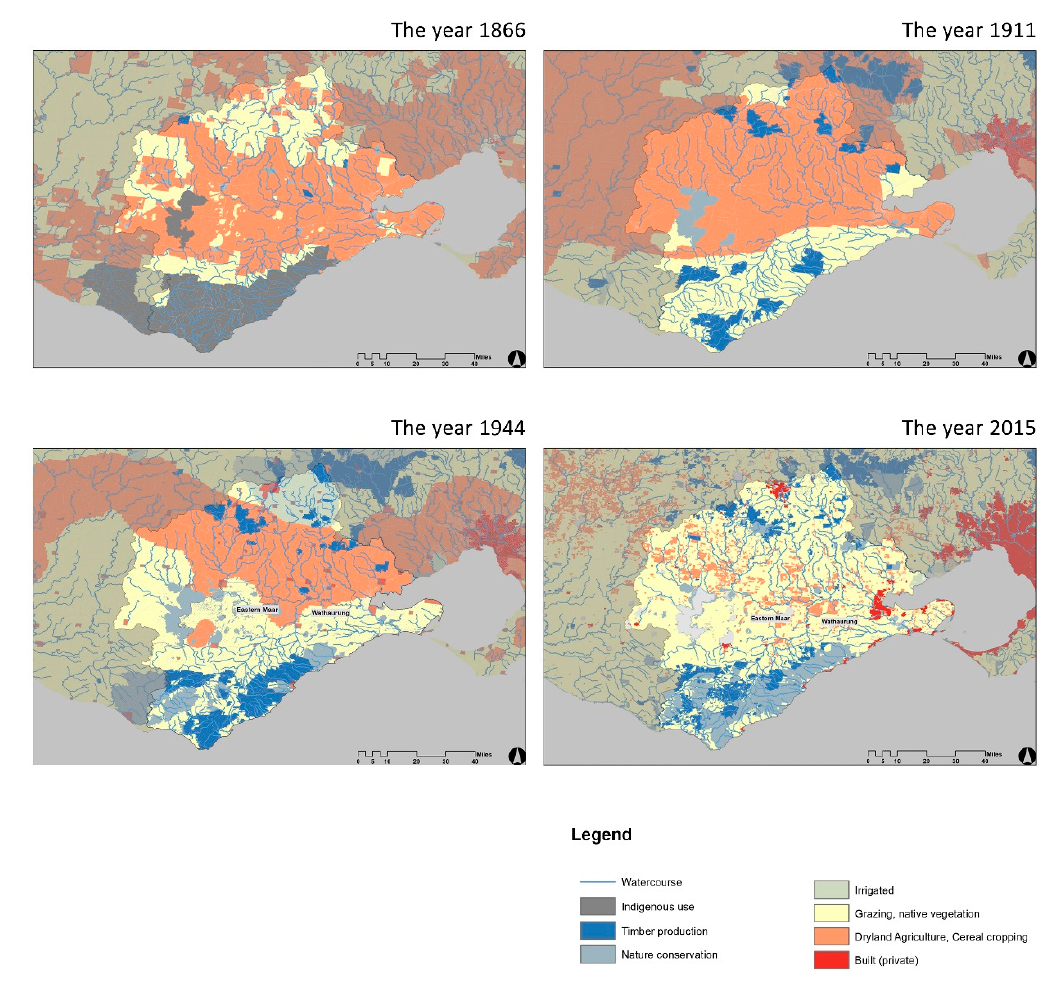
Figure 2. The historical iteration of land-use patterns.